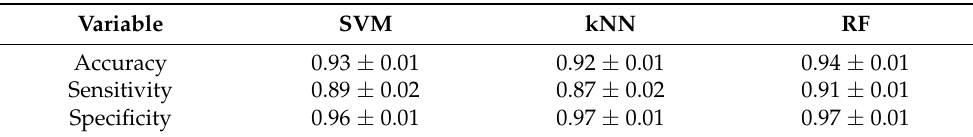
Table 2. Performance metrics for each classifier, SisFall test set for non-overlapping approach (0% overlapping epochs). All classifiers have been trained on a SisFall set and evaluated using a SisFall test set, from which the metrics have been calculated. Each classifier yielded similarly high classification metrics. The values are mean ± standard deviation.